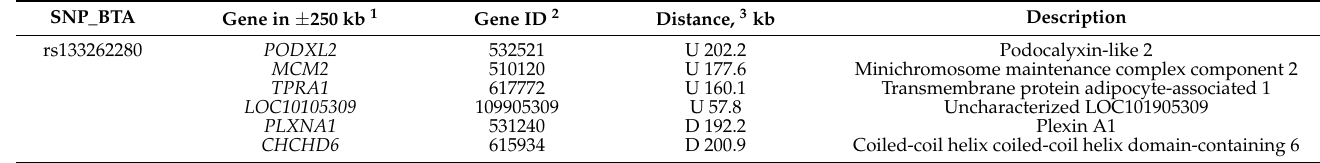
Table 4. Genes close to the SNP rs133262280_22 associated with birth weight of Braunvieh cattle.